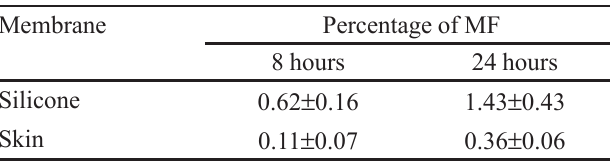
TABLE V - Percentage of mometasone furoate through silicone membrane and human skin (mean ± SD; n = 6).